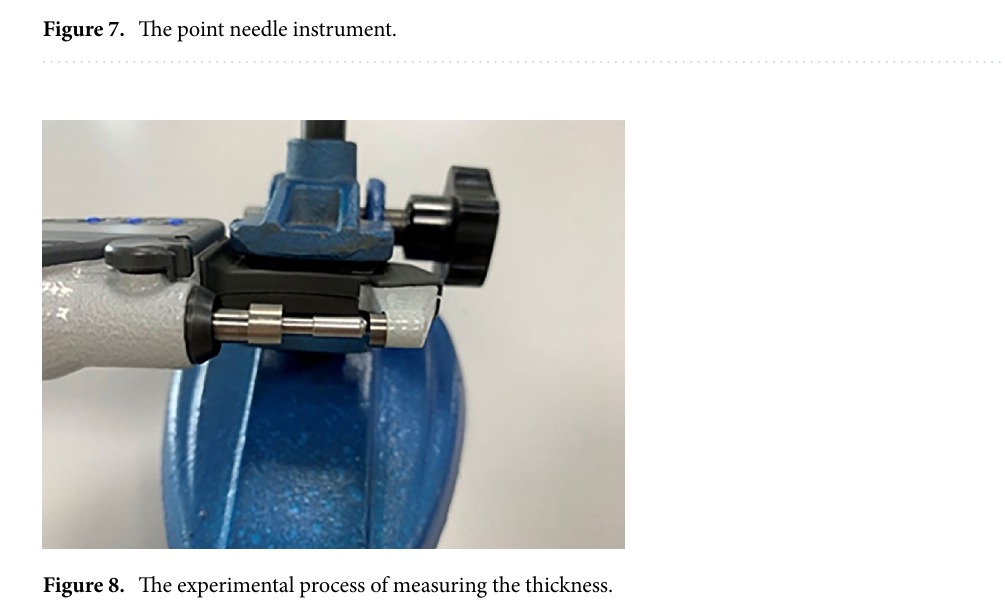
Figure 8. The experimental process of measuring the thickness.